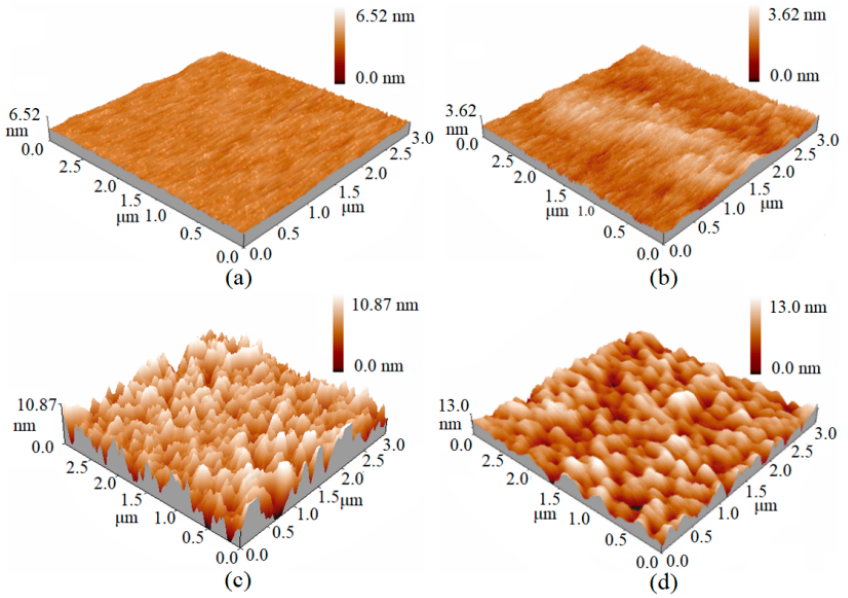
Figure 2. The 3D Atomic Force Microscope (AFM) images of Si-doped GaAs before ( a ) and after ( b – d ) γ -radiation. The gamma doses are 0, 0.1, 1 and 10 KGy.